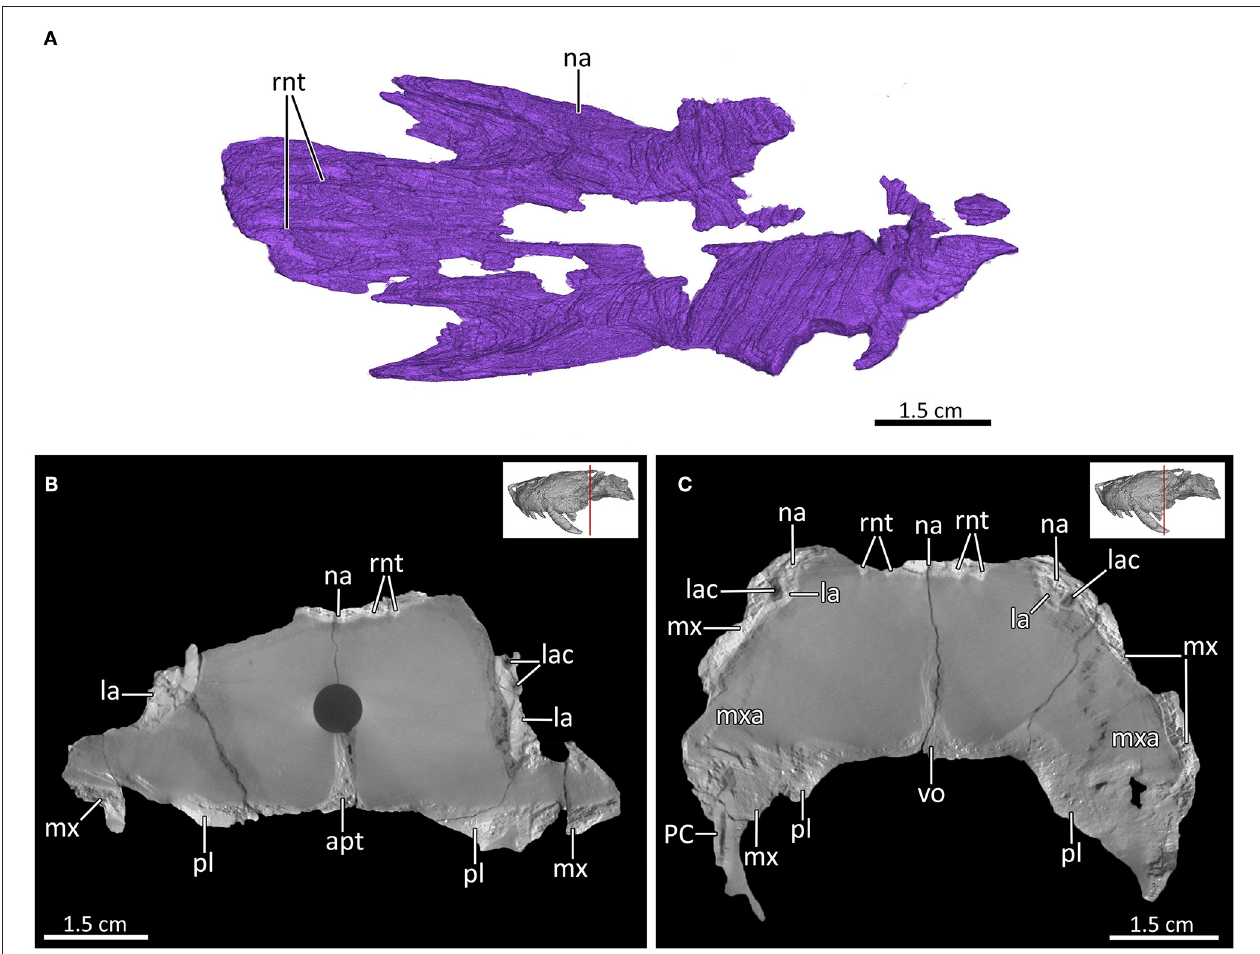
FIGURE 9 | (A) 3D reconstruction of the nasals in ventrolateral view. (B,C) Transverse CT sections through posterior nasal region. apt, anterior process of the pterygoid; la, lacrimal; lac, lacrimal canal; maxilla; mxa, maxillary antrum; na, nasal; PC, upper postcanine; pl, palatine; rnt, ridges for cartilaginous nasal turbinals; vo,